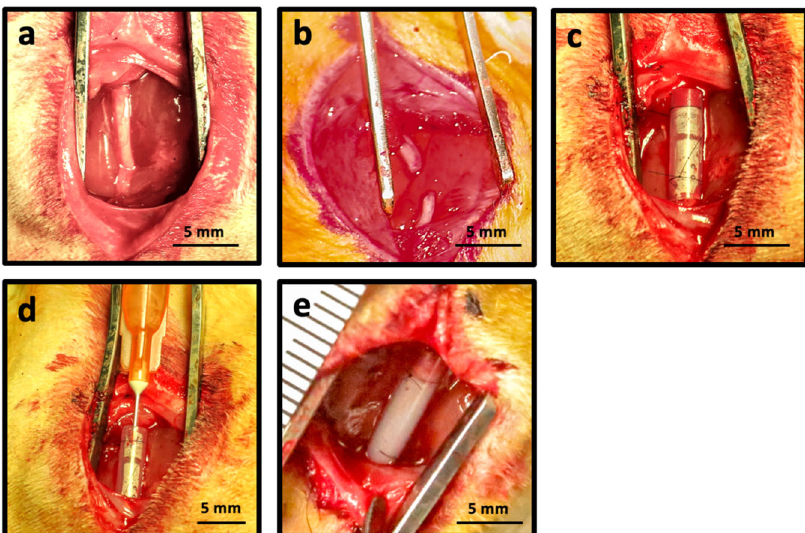
Fig. 1 Subcritical gap injury model and application of PNM. a The left sciatic nerve is exposed at least 5-mm proximal to the sciatic bifurcation. b The nerve is transected, and an 8 mm segment is resected. c Nerve stumps are sutured 1 mm into each end of a 10 mm silicone conduit (2 mm inner diameter). d PNM is delivered into the conduit. e Gelation occurs within 5 minutes following delivery.